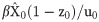
The impact of trafficking on ongoing replication can be understood by focusing on the dynamics concerning the drug sanctuaries.The effective reproductive number can be understood by focusing on just the dynamics concerning infected cell numbers in the drug sanctuaries (Y0) when the drug sanctuaries hold only a small fraction of the body’s CD4 T cells. Under this assumption the net traffic of infected cells out of the drug sanctuaries is approximately κτ0Y0 day-1 (see S1 Text for details). The dynamics of infected cells in the drug sanctuaries will therefore be governed by a single influx rate (new infections at rate βX^0(1−z0)/u0 day-1) and two efflux rates (cell clearance at rate δ0 Y0 day-1 and cell egress at rate κτ0Y0 day-1).